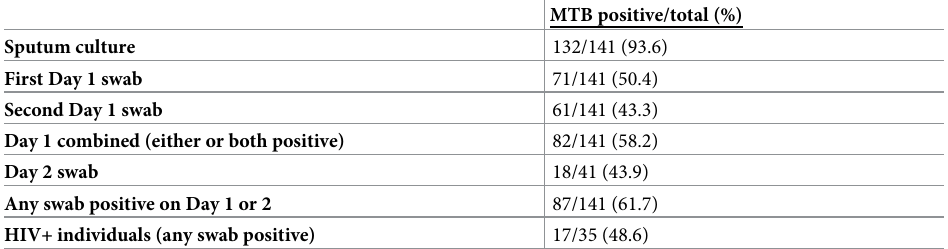
Table 5. Tuberculosis culture positivity among tongue swab samples from Xpert positive individuals.